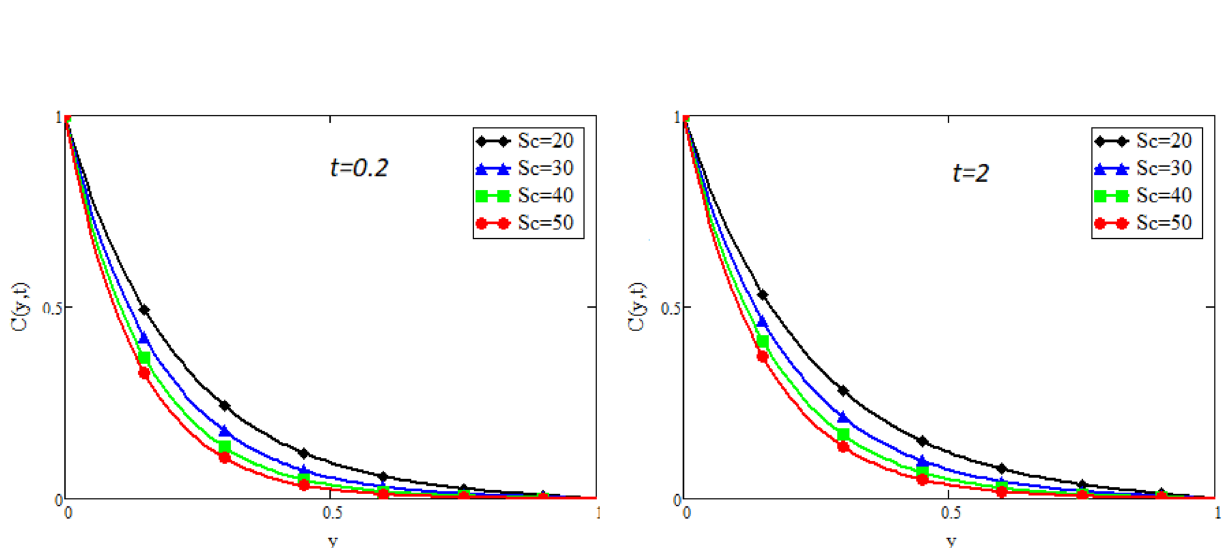
Figure 12. Impact of Sc on concentration